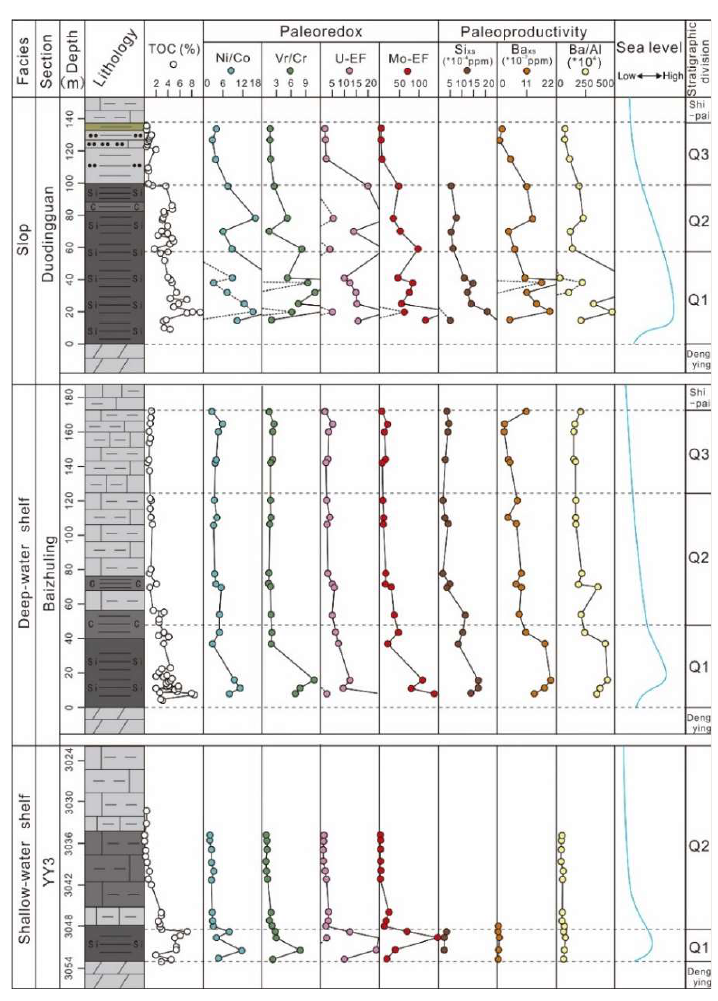
Figure 4. Variations in the TOC content, paleo-redox conditions, paleo-productivity, and sea level in the different zones during the deposition of the Qiongzhusi Formation in the study area (see Figure 2 for lithology legend).